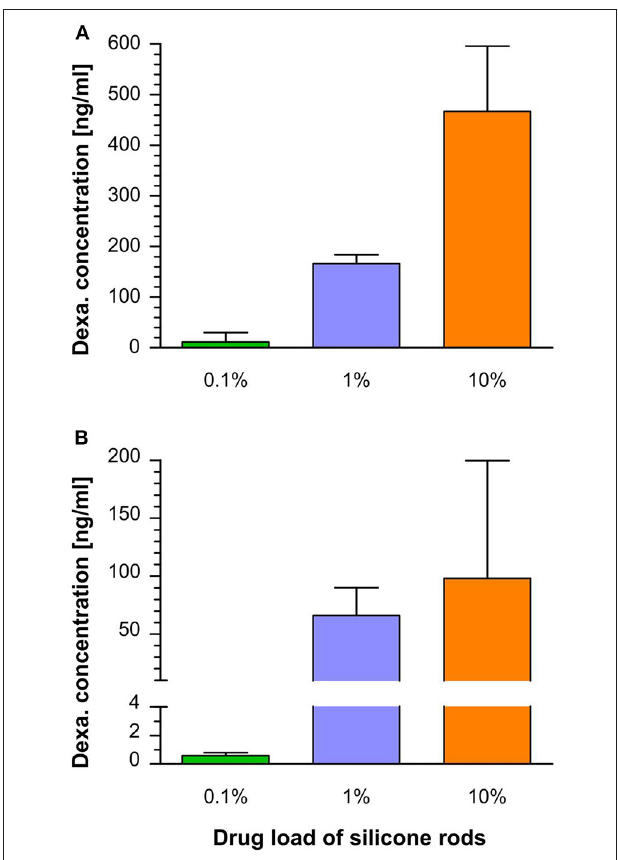
FIGURE 5 | (A) Perilymph dexamethasone concentration in the scala tympani during the burst release phase (mean and SD) measured on day 1 after implantation for the three tested loaded rods (see Figure 4A ). A higher drug load resulted in an increased burst release, showing an exponential tendency. (B) Perilymph dexamethasone concentration in the scala tympani during the steady state release phase (mean and SD). Calculation based on perilymph drug concentrations at the following time points: 0.1%: 3–7 days, 1%: 3–49 days, 10%: 7–49 days (see Figure 4A ). The dexamethasone perilymph concentrations during the steady state release phase increased with higher drug load, showing a logarithmic